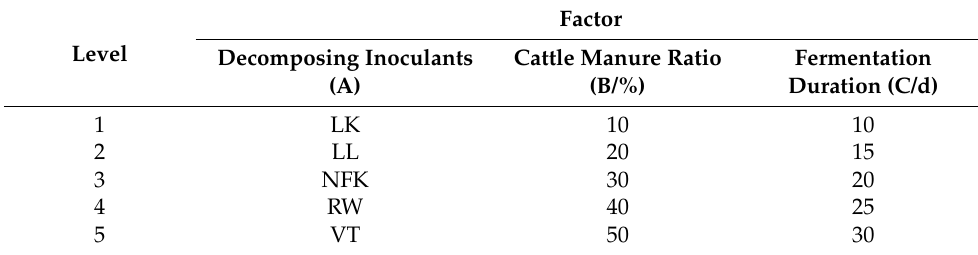
Table 2. Orthogonal experimental factors and